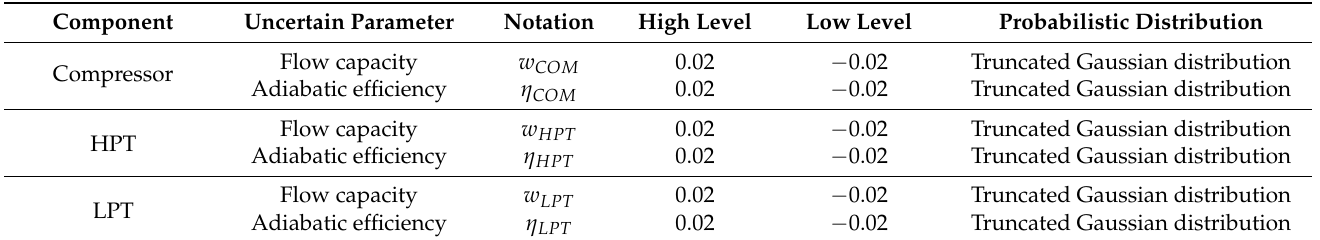
Table 3. The description of the uncertain